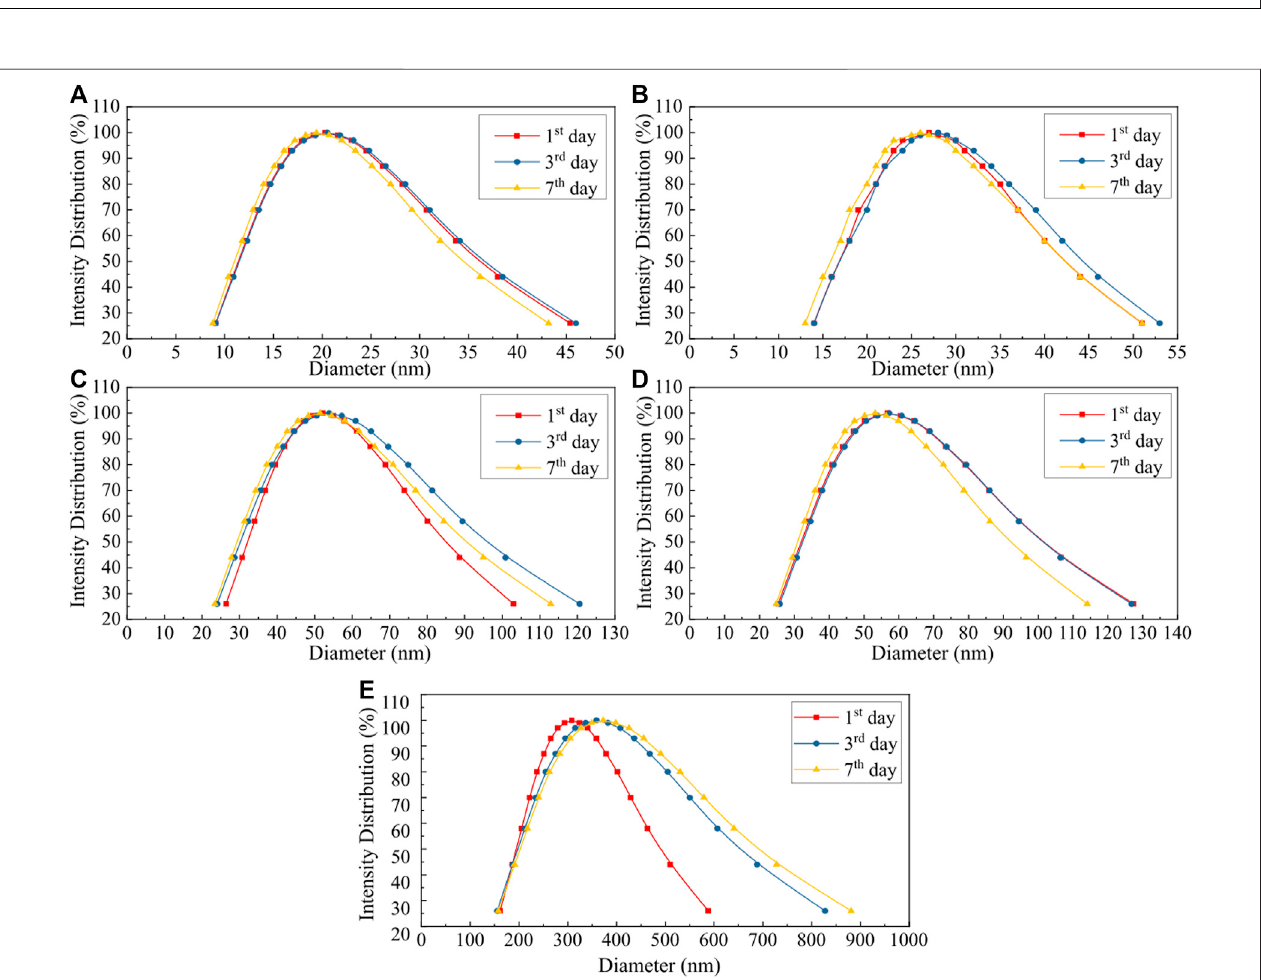
FIGURE 4 | Particle size distribution in the nano fl uid in different days after its preparation via dynamic light scattering (DLS) analysis. (A) TiO 2 /H 2 O, φ (cid:1) 0.05 vol%; (B) TiO 2 /H 2 O, φ (cid:1) 0.15 vol%; (C) TiO 2 /H 2 O + EG (3:2), φ (cid:1) 0.05 vol%; (D) TiO 2 /H 2 O + EG (1:1), φ (cid:1) 0.05 vol%; (E) Al 2 O 3 /H 2 O, φ (cid:1) 0.05